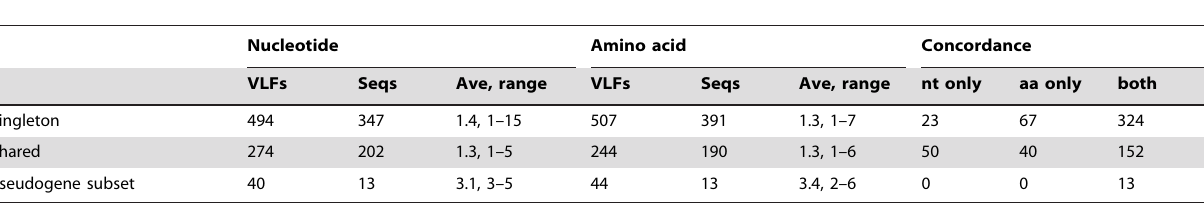
Table 2. Singleton and shared very low frequency (VLF) variants in avian BARCODEs.